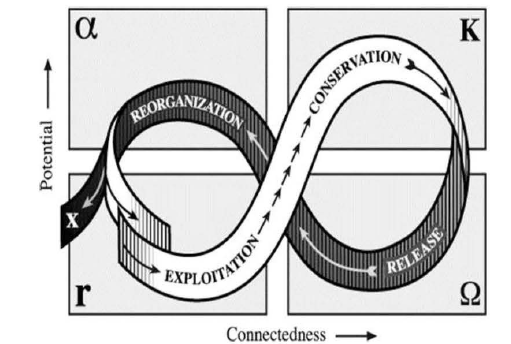
identified: (1) growth or exploitation (r), (2) conservation (K),